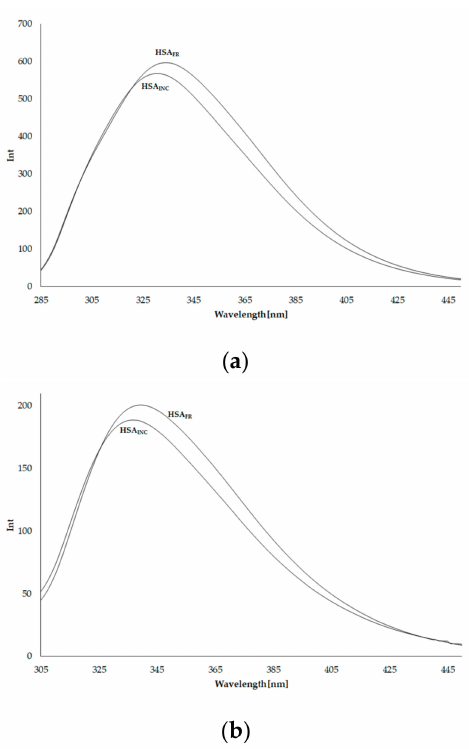
Figure 3. Emission fluorescence spectra of unmodified human serum albumin (HSA FR ) and incubated human serum albumin (HSA INC ) at 5 × 10 − 6 mol · L − 1 concentration; ( a ) λ ex 275 nm, ( b ) λ ex 295 nm.